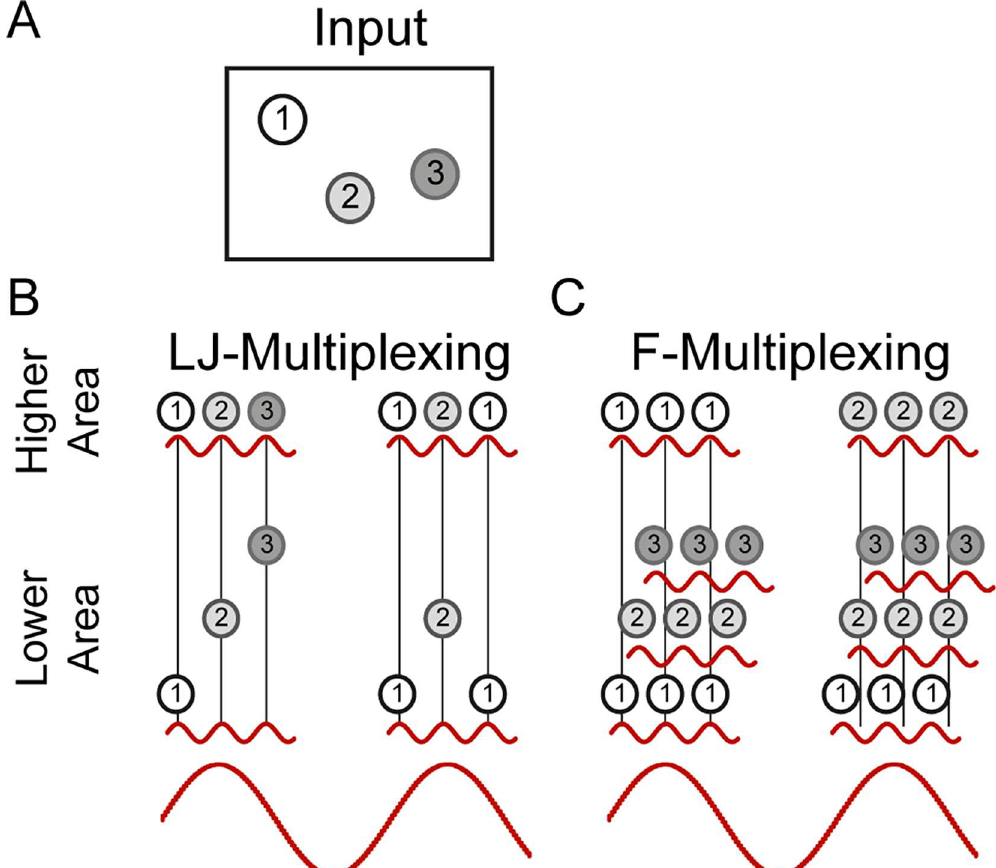
Fig 1. Comparative illustration of multiplexing theories. A. Consider a simple scene comprising 3 discrete objects of different saliency. B. LJ-multiplexing. Multiple Items are processed across consecutivefast cycles in decreasingorder of saliency, and this sequenceis repeated over slow oscillatory cycles. Note that items of low saliency may not be processedat all. C. F-multiplexing. Within any given slow cycle, only a single item is represented, repeatedacross multiple fast cycles. Across slow cycles, the represented item may switch, due to changes in the stimulus or top-down attentionalmechanismsaltering relative stimulus saliency.